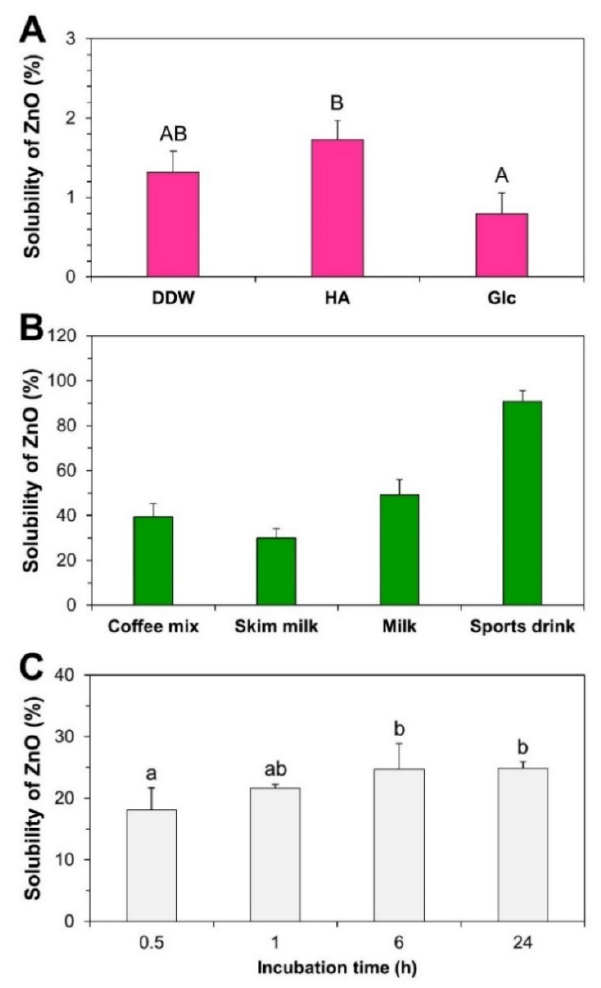
Figure 3. Dissolution properties of ZnO NPs in ( A ) dispersants, ( B ) food matrices, and ( C ) cell culture medium. Different upper-case letters (A,B) indicate significant differences among different dispersants ( p < 0.05). Different lower-case letters (a,b) indicate significant differences among incubation times ( p < 0.05).